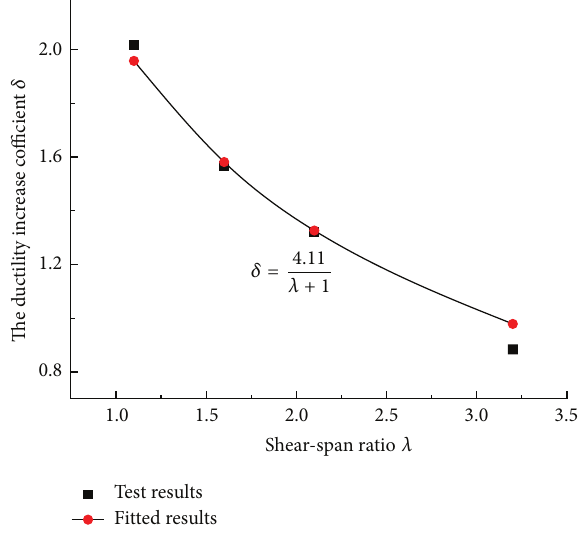
Figure 6: 𝛿 - 𝜆 according to